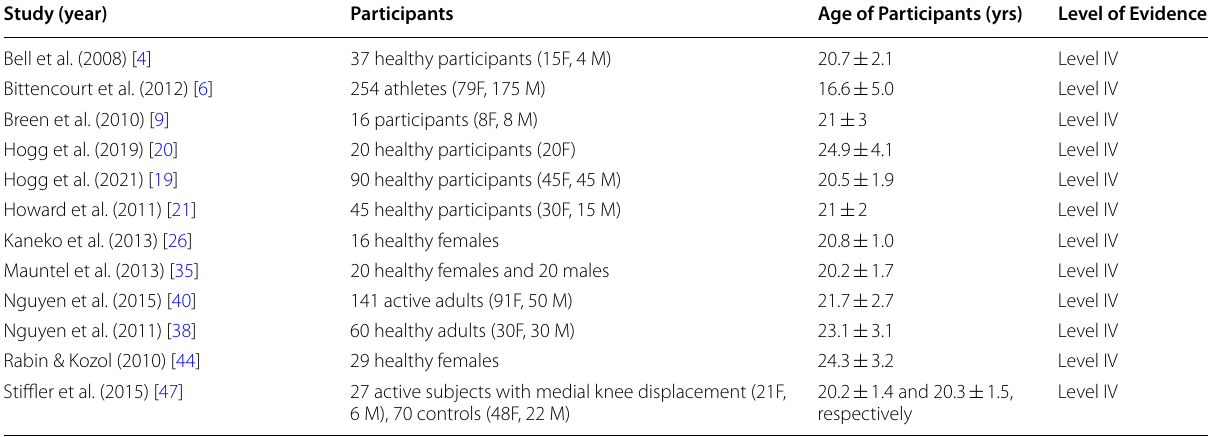
Table 3 Characteristics of included biomechanical